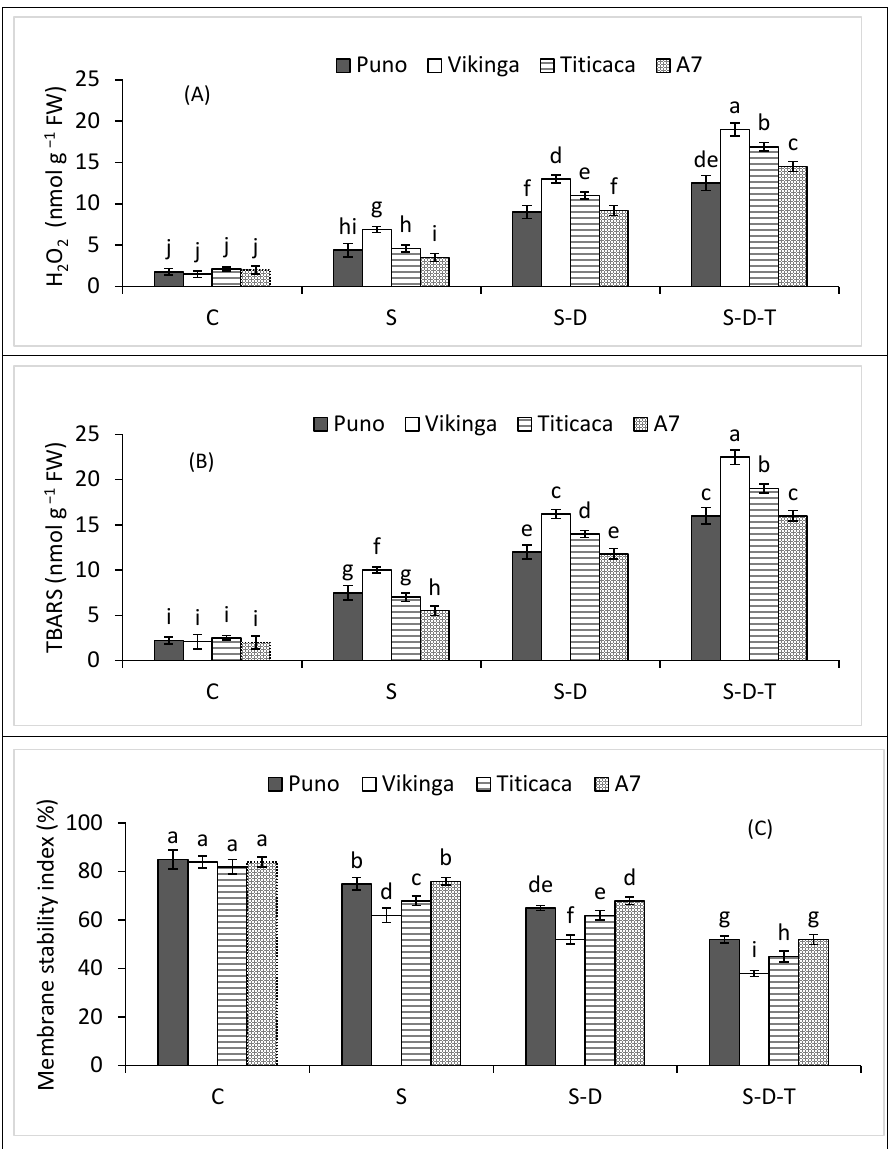
Figure 4. ( A ) H 2 O 2 contents, ( B ) TBARS contents, and ( C ) membrane stability index of quinoa genotypes under control (C), salinity (S), drought (D), and high-temperature (T) stress. S-D, combined salinity and drought treatment; S-D-T, combined salinity, drought, and high-temperature treatment. The values for each parameter are the means of three replicates ± SE. At the 5% probability level, bars with different letters indicate significant